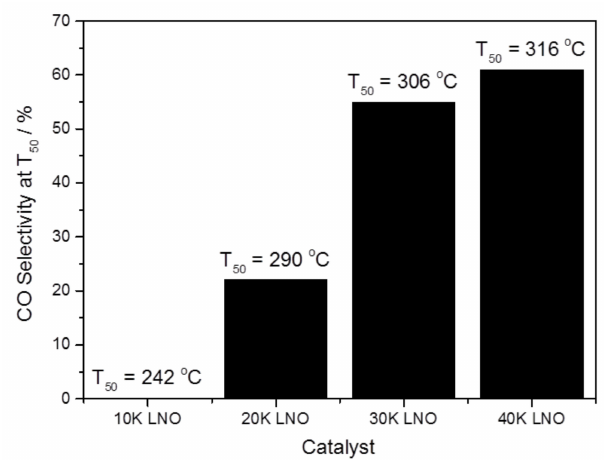
Figure 7. Selectivity towards the rWGS at T 50%